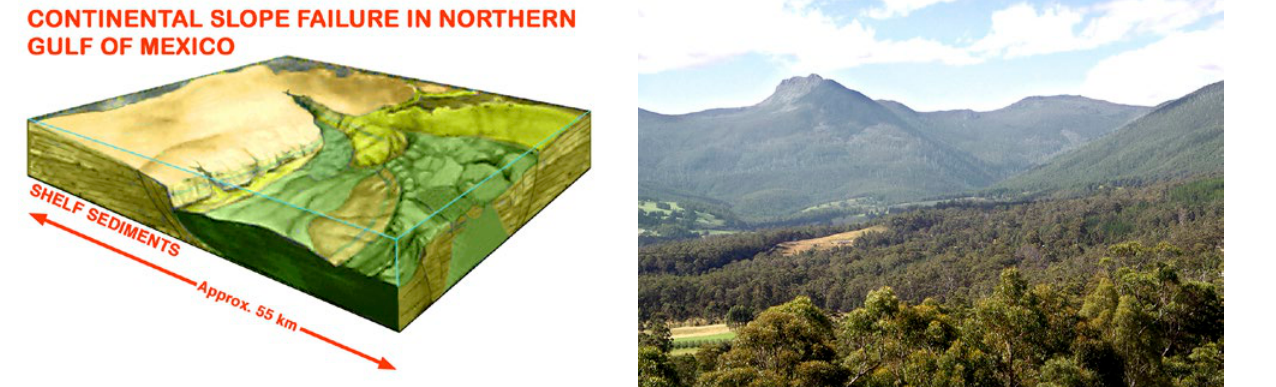
Figure 38. Liquefaction and displacement of large volumes of wet sediment result from submarine slope failure.